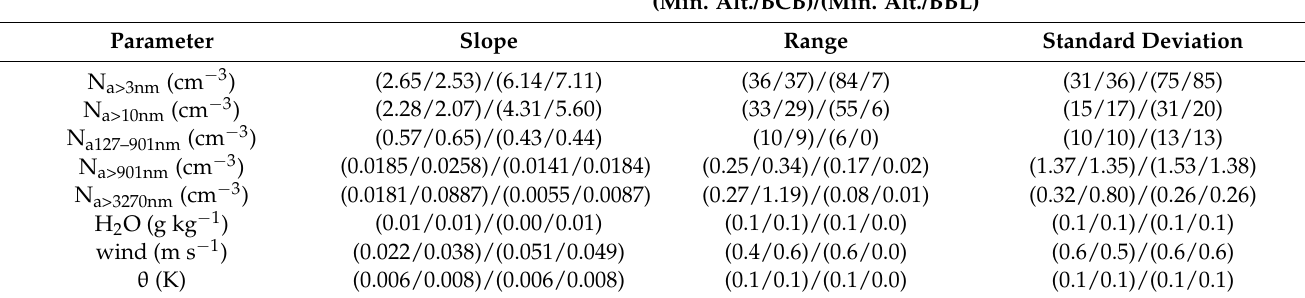
Table 4. Median values for calculated quantities along individual leg types in MONARC 2019 flights, including the absolute value of the slope of each variable along a leg type (in native units below per km), the “range” (slope multiplied by the distance of a leg type), and the standard deviation. Slopes represent the absolute value to remove any dependence on the direction the aircraft flew in. Standard deviations along single legs were calculated after detrending the data along each leg using linear best fit information as demonstrated in Figure S3.